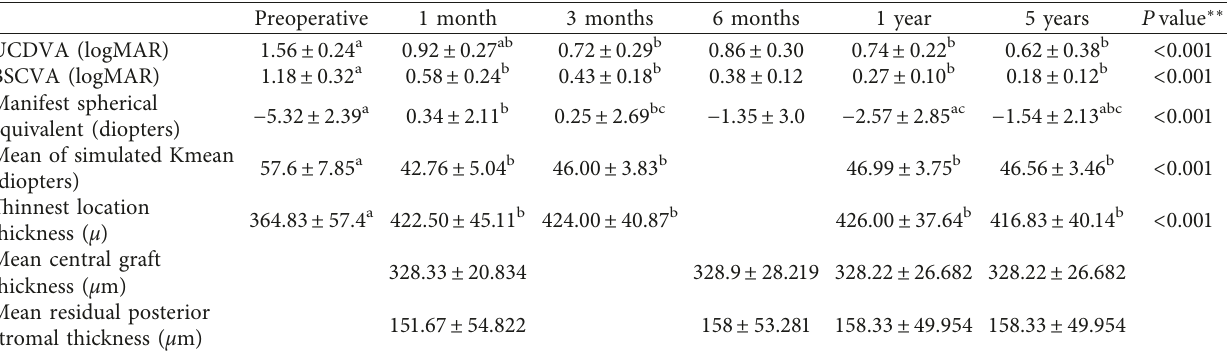
Table 1: Preoperative and postoperative UCDVA, BSCVA, MSE, mean of simulated Kmean, thinnest location thickness, and postoperative mean central graft thickness and mean residual posterior stromal